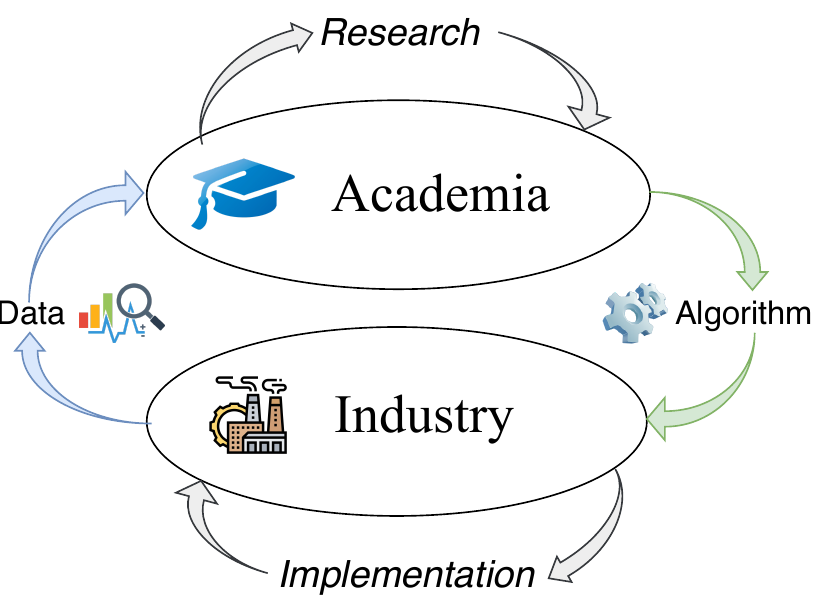
Figure 1. A typical cycle of advanced process control development: data are collected on the factory floor and shared with academic researchers; the data are processed, relevant research is conducted, and a control algorithm is designed and finally transferred back to the industrial plant where it is then